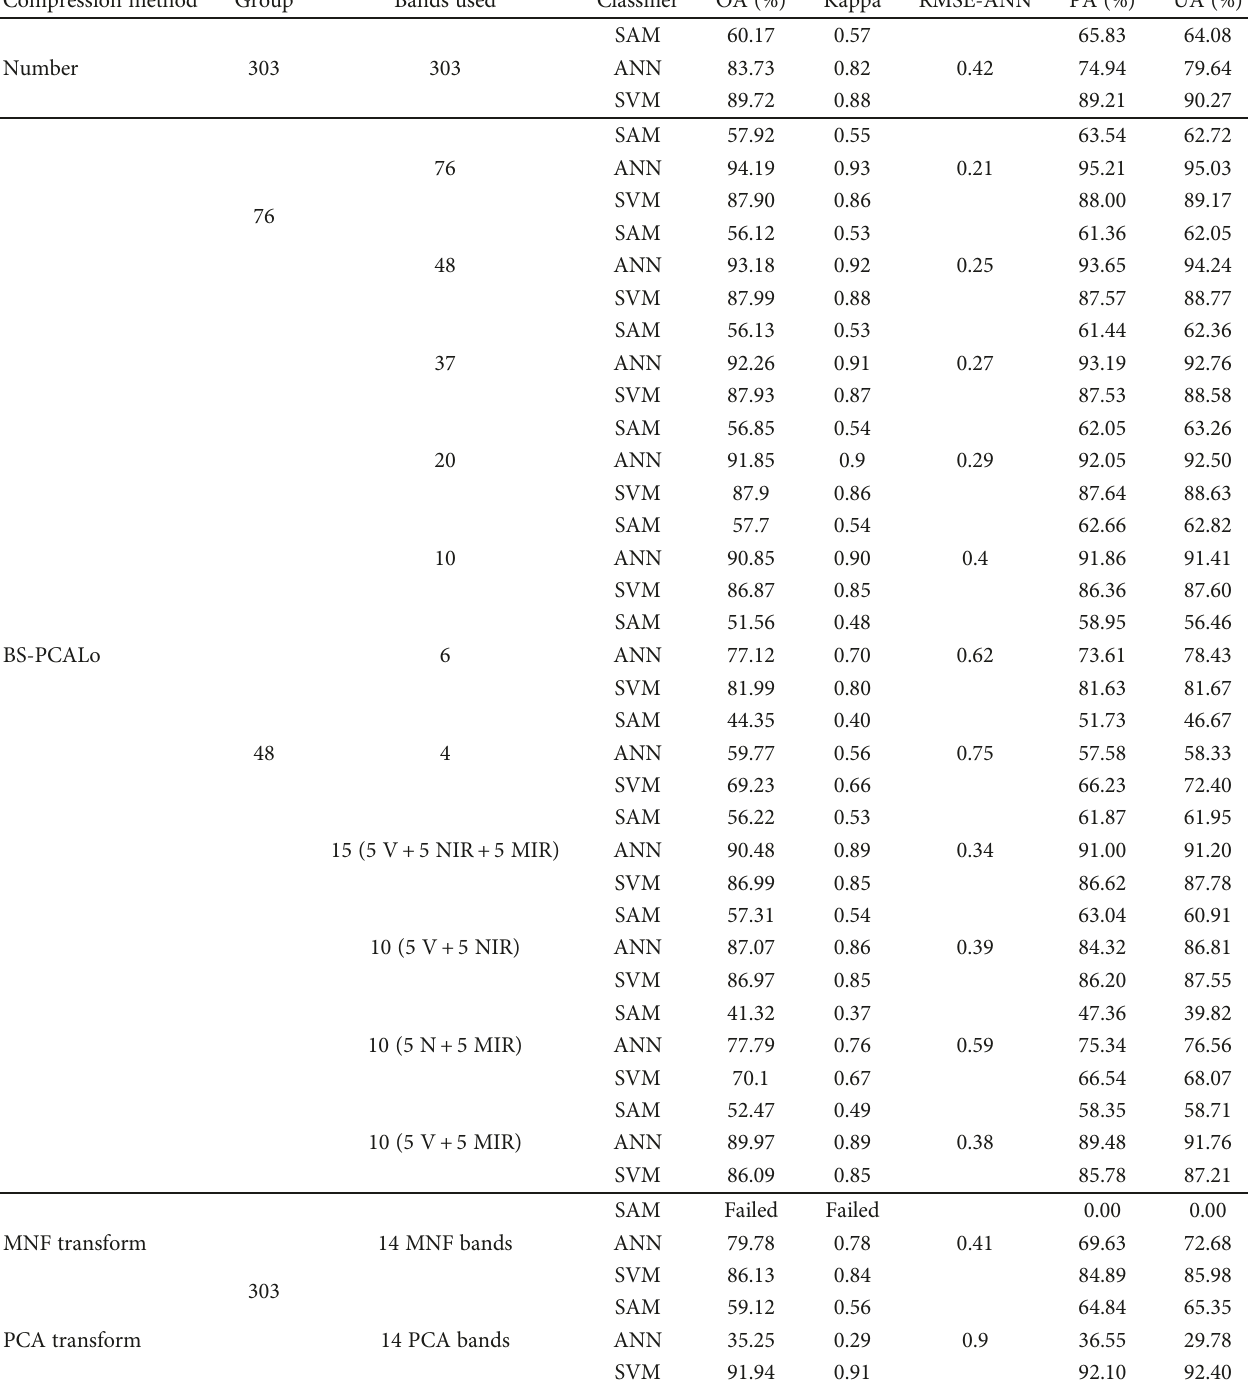
Table 1: Classi fi cation